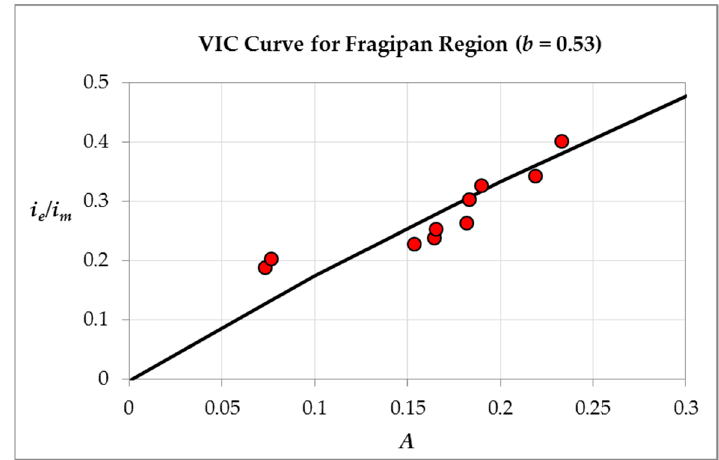
Figure 3. Calibrated variable infiltration curve for fragipan sites in ORW showing data points computed with the effective soil moisture capacity approach.